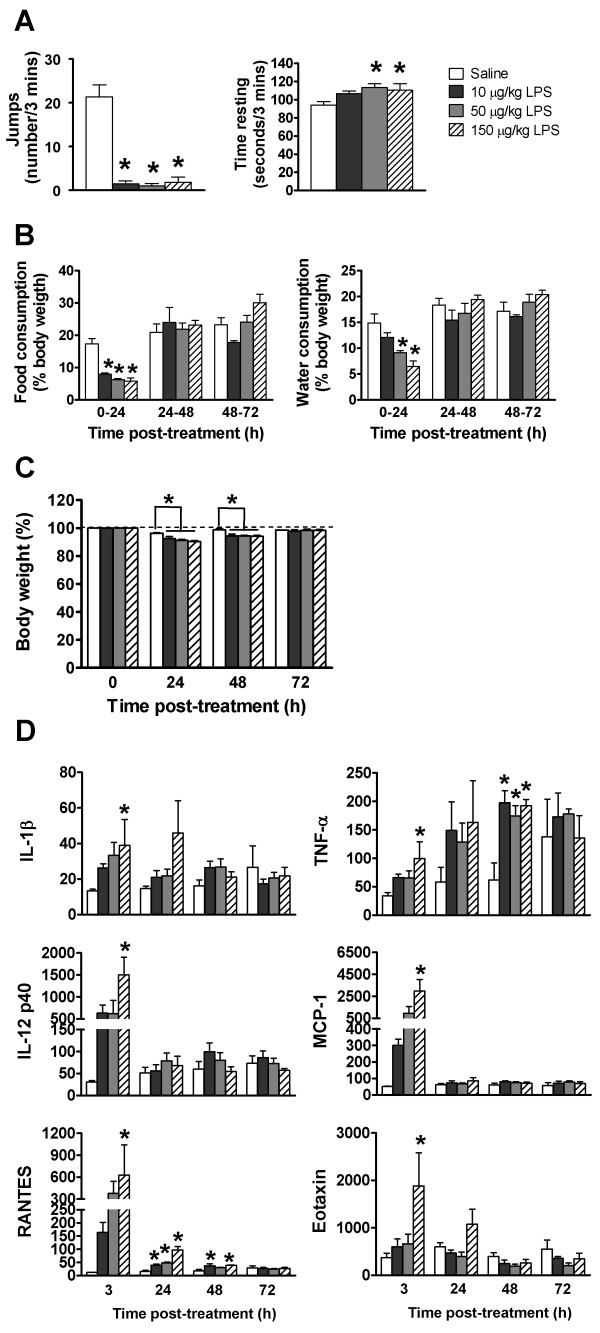
Maternal inflammatory response following treatment with saline or LPS doses. LPS treatment (particularly 50 and 150 μg/kg) (A) reduced jumping activity and increased time spent resting in an open-field test at one hour posttreatment, (B) reduced food and water consumption during the first 24 hours posttreatment, (C) reduced body weight at 24 and 48 hours posttreatment (dashed line = preinjection body weight) and (D) increased serum concentration (pg/mL) of inflammatory cytokines posttreatment. Maternal body weight at each 24-hour interval posttreatment is expressed as a percentage of pretreatment body weight, as were food and water consumption during each 24-hour period posttreatment. All values represent means ± standard error of the mean (SEM). *P ≤ 0.05 vs. control (n = 5 to 7 mothers per treatment).